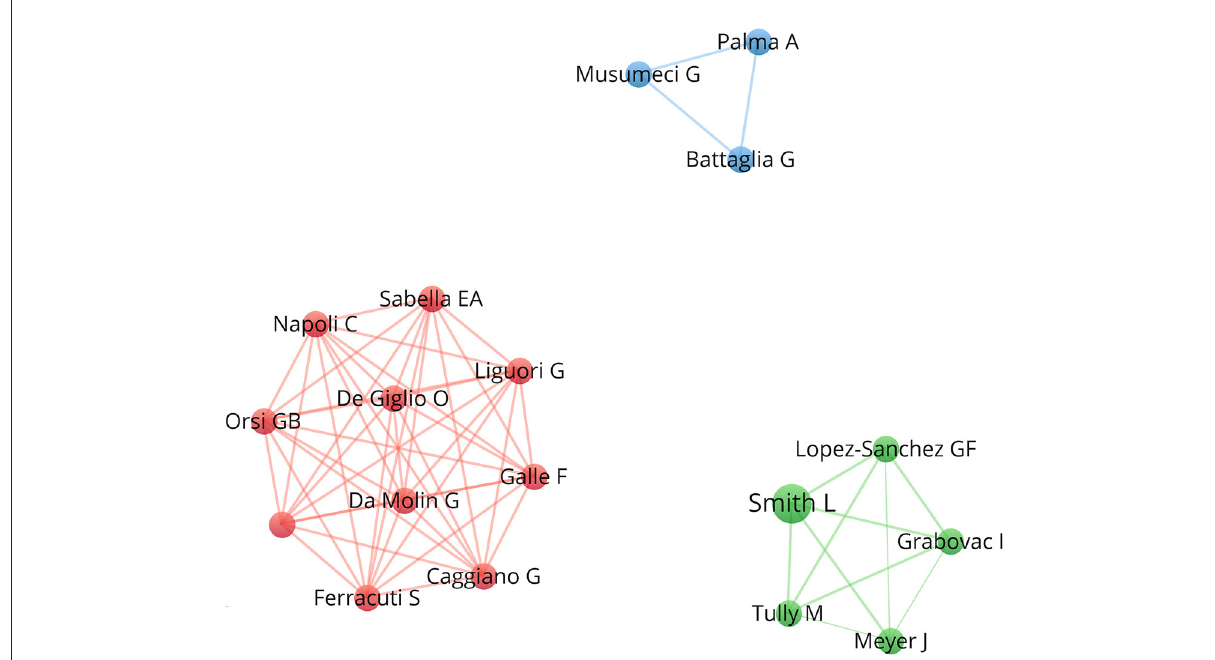
FIGURE4 Authors Cooperation Network Mapping.